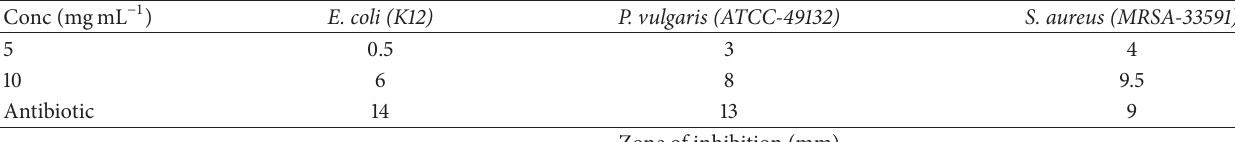
Zone of inhibition (mm)